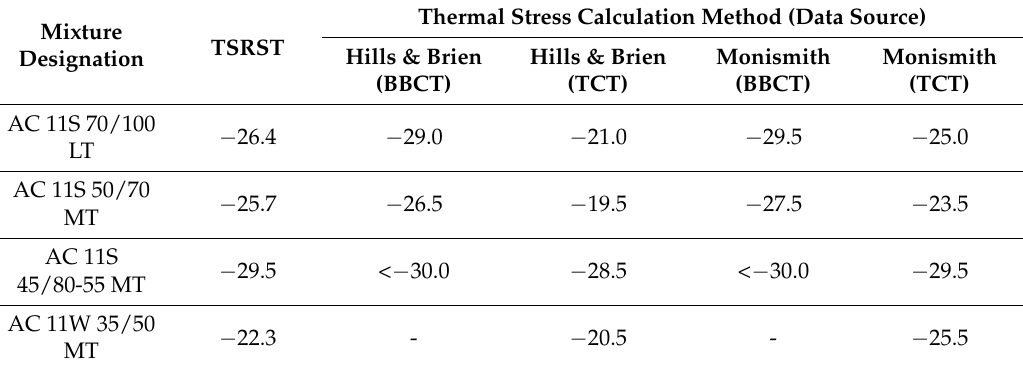
Table 8. Comparison of predicted failure temperatures (mean